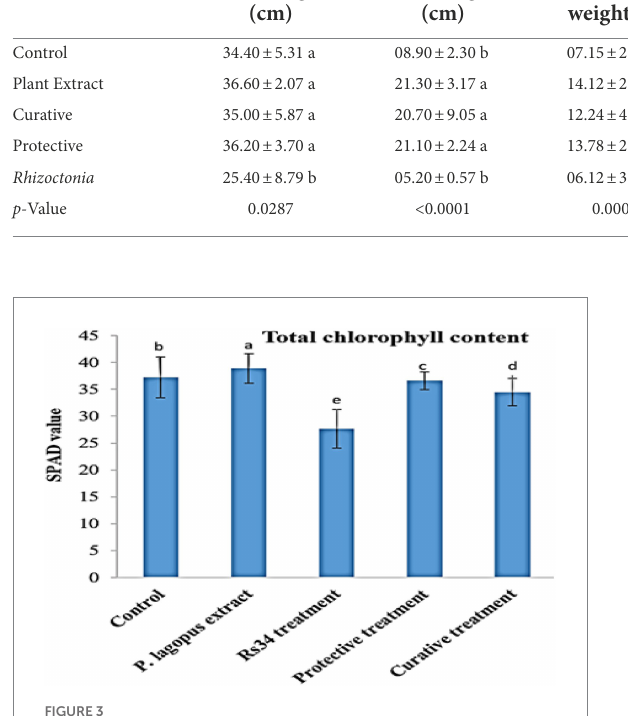
TABLE 4 Effect of treatment with Plantago lagopus extract on growth parameters of tomato plants. Treatments